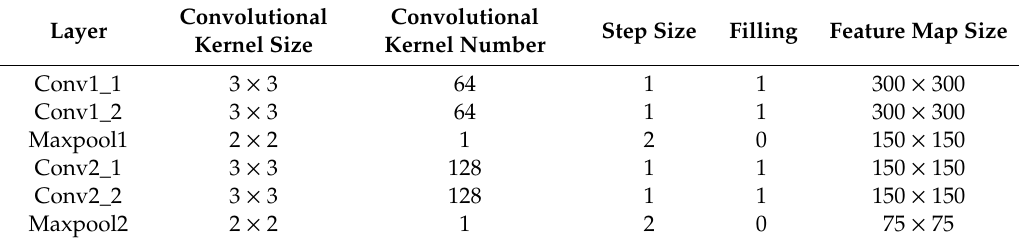
Figure 1. The basic structure of the SSD network model. Table 1. The main parameters of the SSD network model.